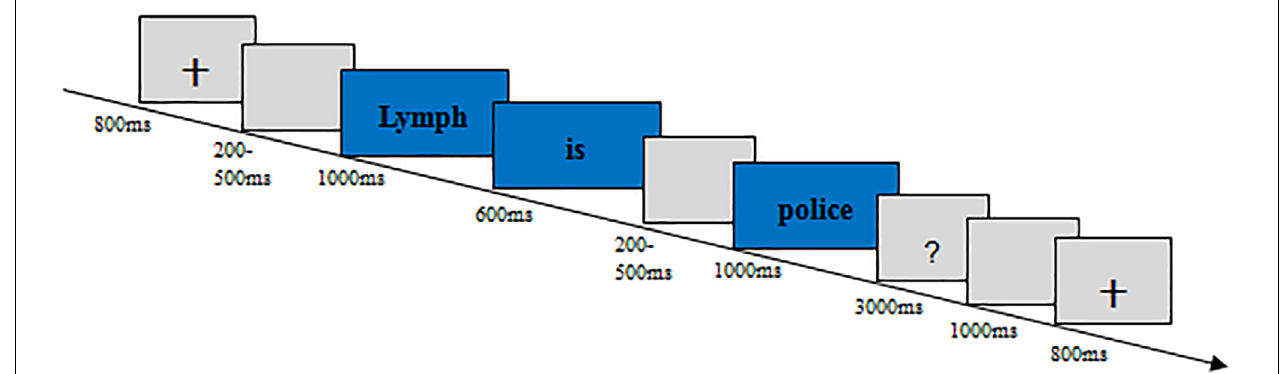
FIGURE 4 | The procedure of Experiment